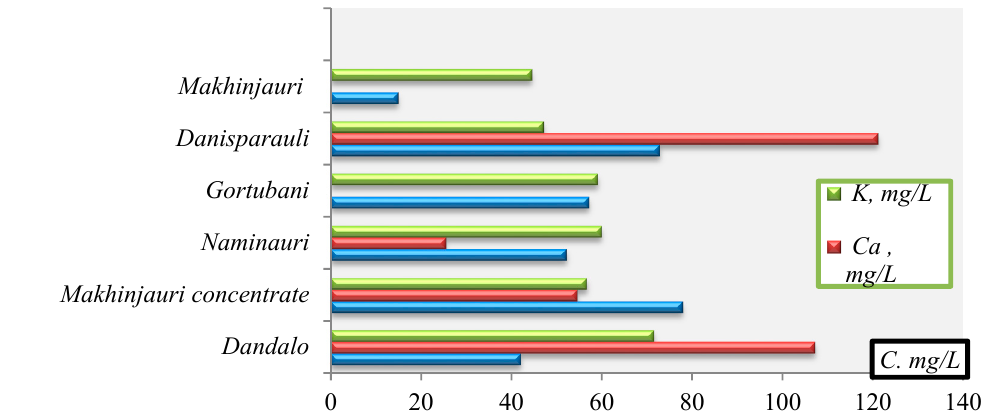
Figure 9. The content of B , Fe and Cr in the Adjarian and Adigeni regions mineral waters.